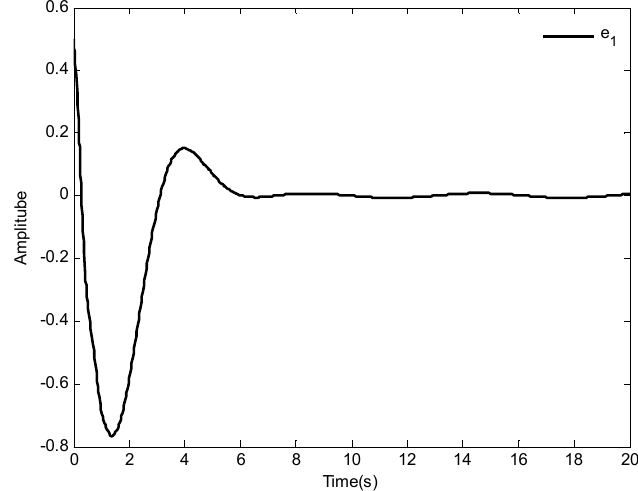
Figure 10. The curve of tacking error.